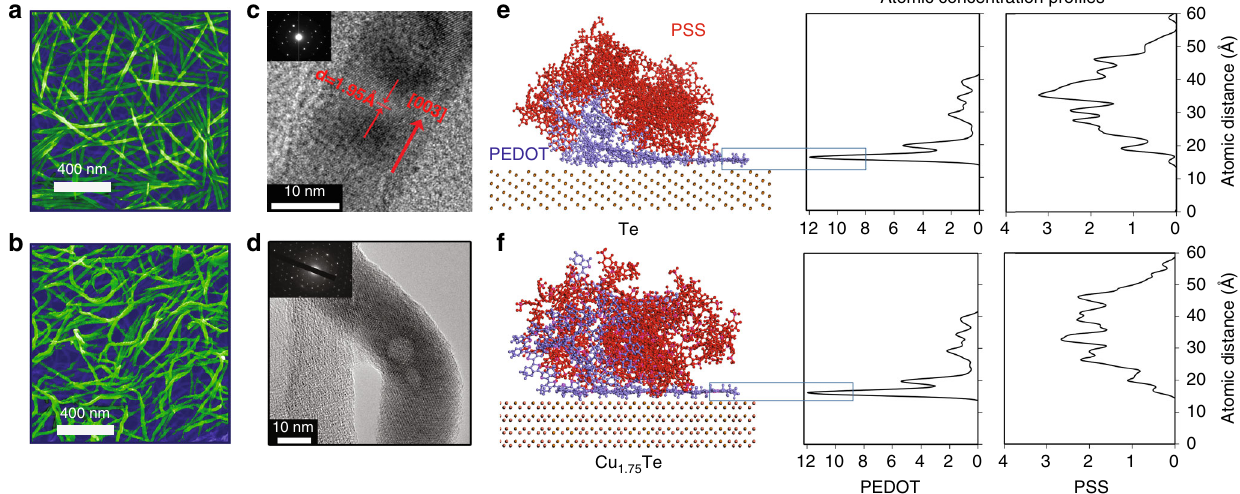
Fig. 1 Morphology of hybrids and alignment of PEDOT:PSS at the inorganic interface ( a , b ) False-color scanning electron microscope (SEM) images of ( a ) PEDOT:PSS-Te and ( b ) PEDOT:PSS-Cu 1.75 Te fi lms illustrate the overall morphology of the hybrid fi lms – inorganic nanowires in a PEDOT:PSS matrix. The green color shows the surface nanowires and blue illustrates the 3D plane underneath, where the PEDOT:PSS polymer matrix is transparent